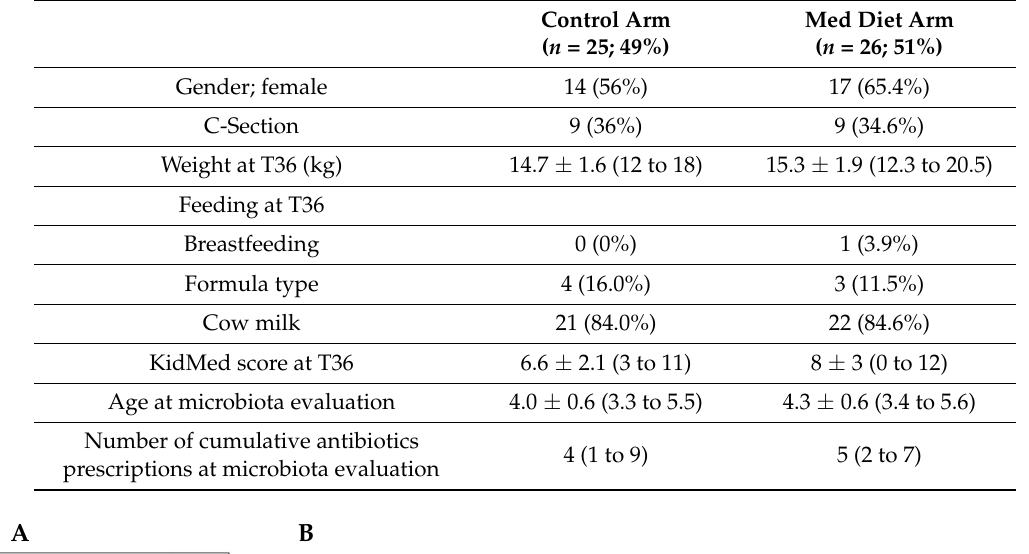
Table 3. Clinical ad demographical characteristics of the children analyzed for microbiota stratified by treatment arm. Variables are described by mean ± standard deviation (min to max), median [25th; 75th percentile] or absolute frequencies (percentage).